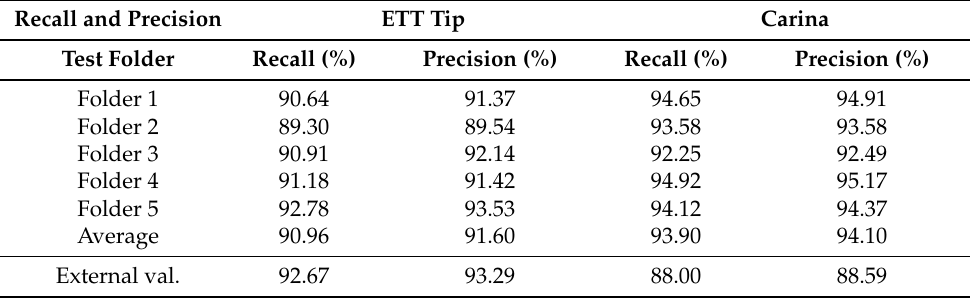
Table 5. The performance in recall and precision.